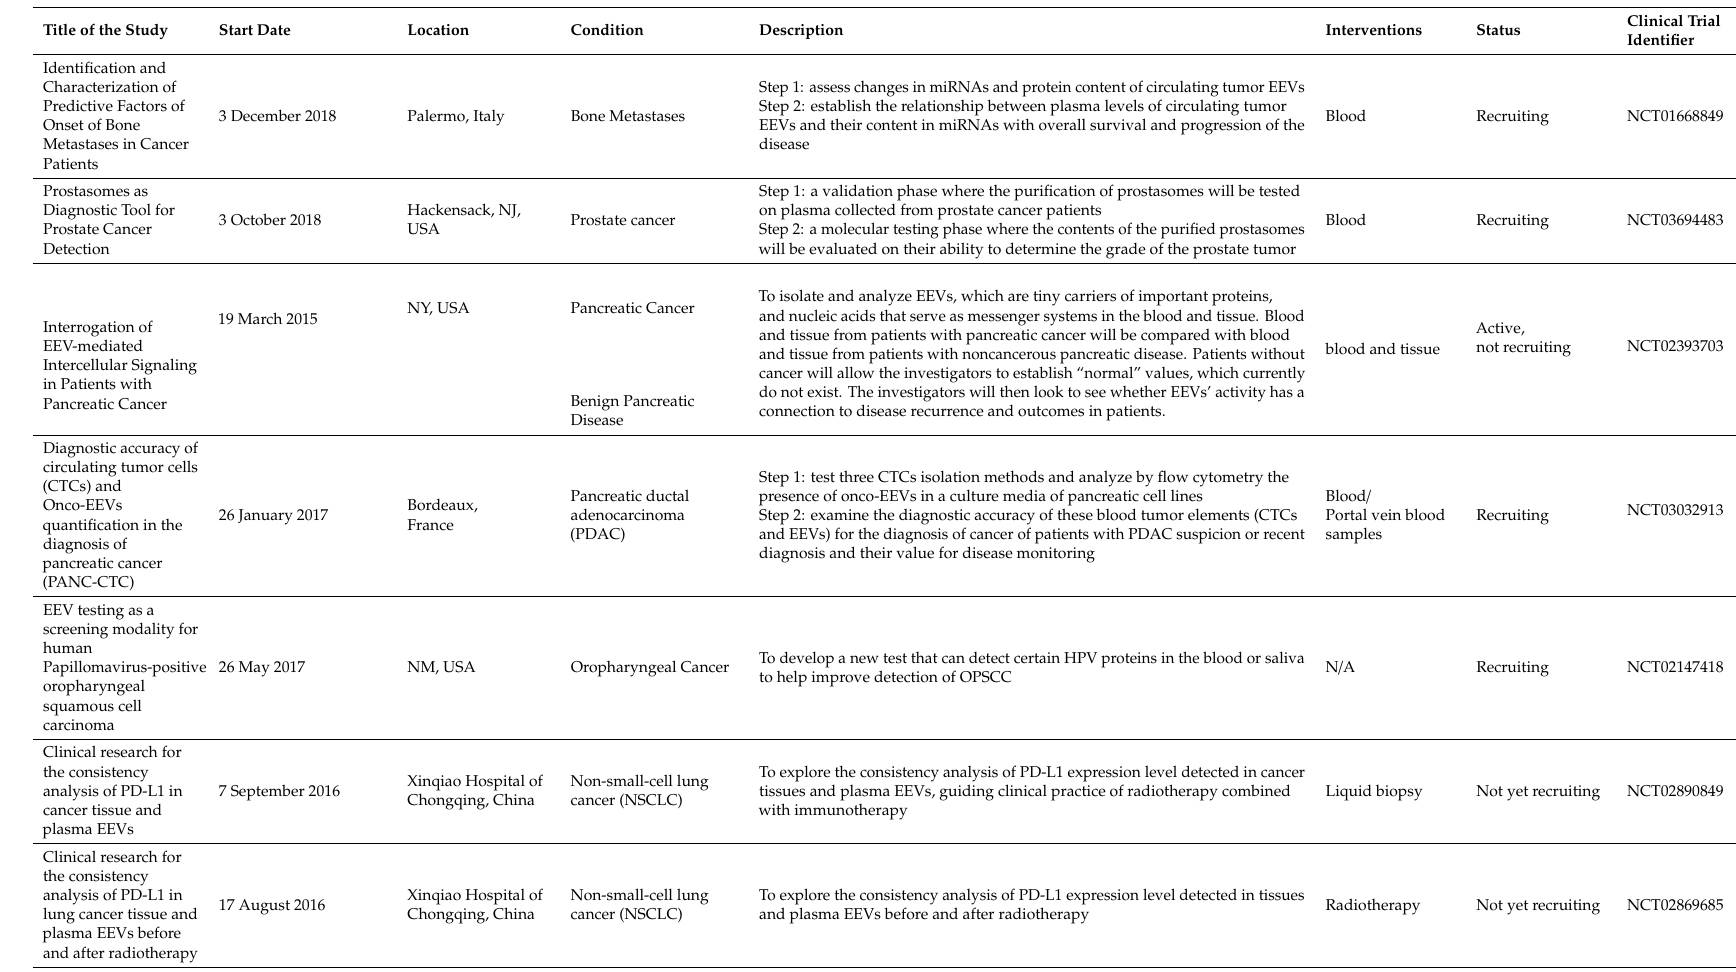
Table 6. EEV clinical trials in cancer